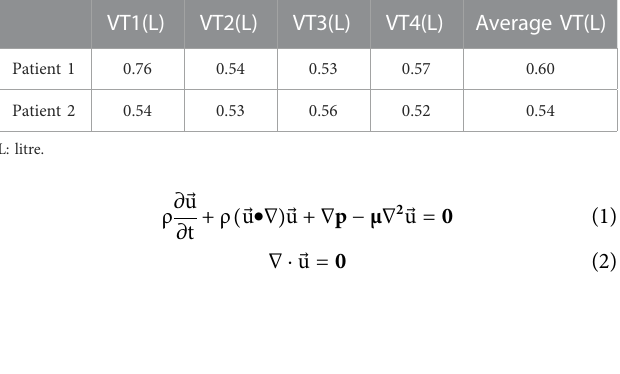
TABLE 1 The tidal volume (VT) of the two